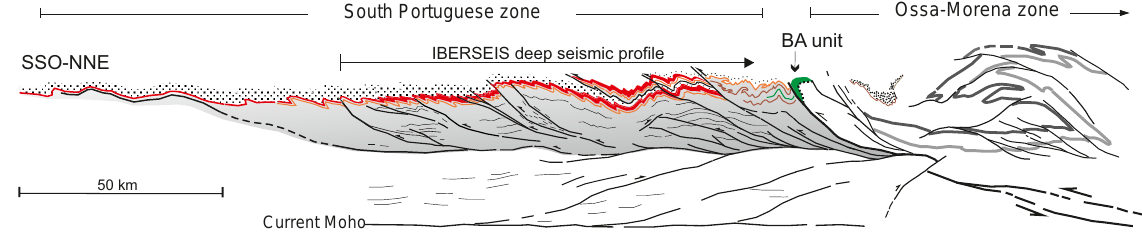
Figure 7. Schematic structural cross section of the southern OMZ and SPZ (modified from Simancas et al., 2003). See Fig. 1c for